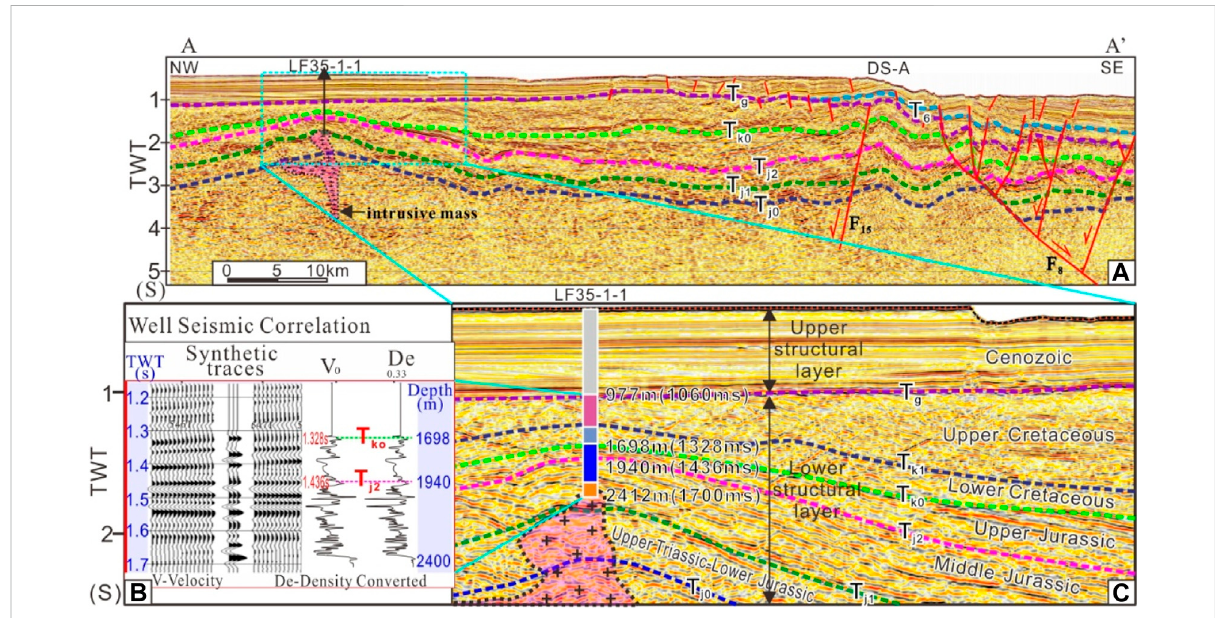
FIGURE 2 Well seismic correlation map. (A) Seismic re fl ection interfaces identi fi ed with the Well LF35-1-1; (B) well seismic correlation by V and De; (C) is the expanded view of (A)